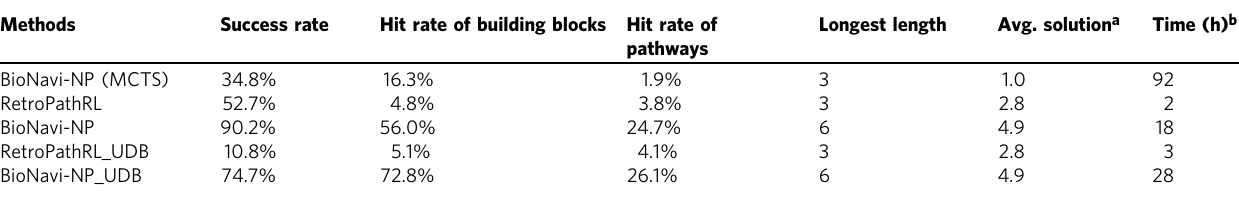
Table 2 Comparison of performance among different models for the test set. Methods